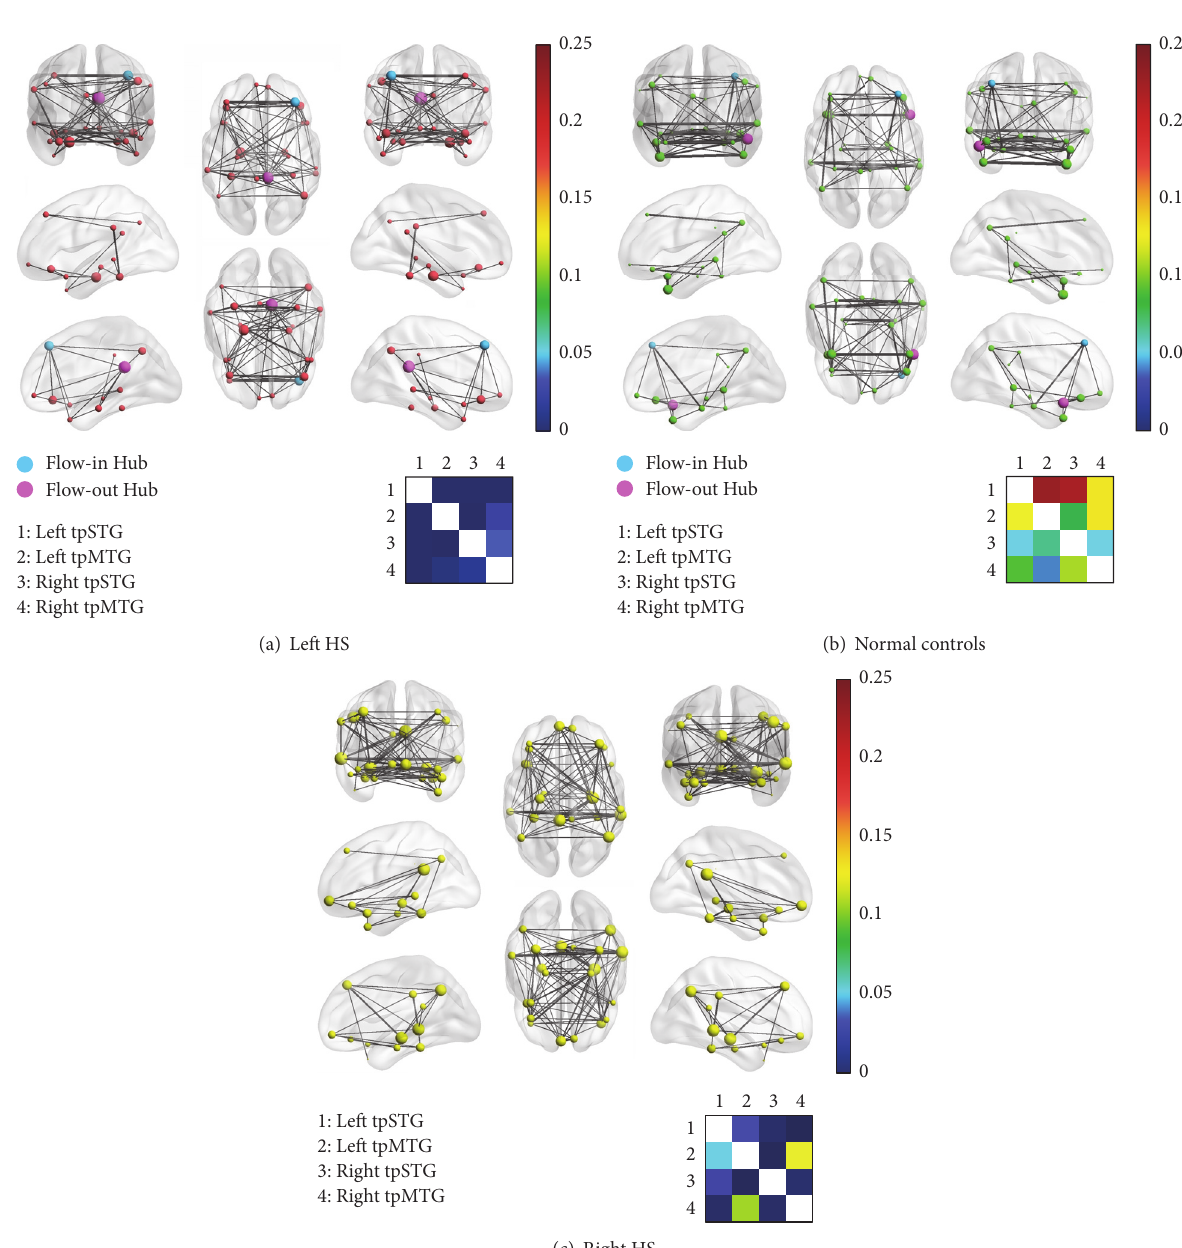
patients compared with normal controls. In detail, increased causal effects were found in the interactions from right AG to right parahippocampal gyrus, from right AG to right SMG, from left MTG to left parahippocampal gyrus, from left tpMTG to left PCC, and from left tpMTG to left MTG; decreased causal effects were found in the interactions from right PCC to left vmPFC, from right fusiform to left fusiform,